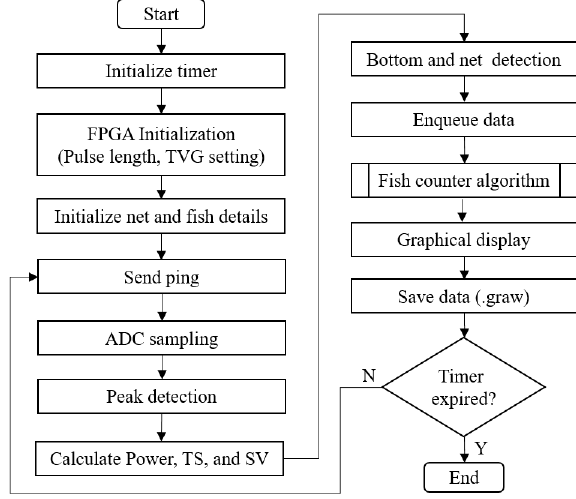
Figure 10. The flowchart of the device software.